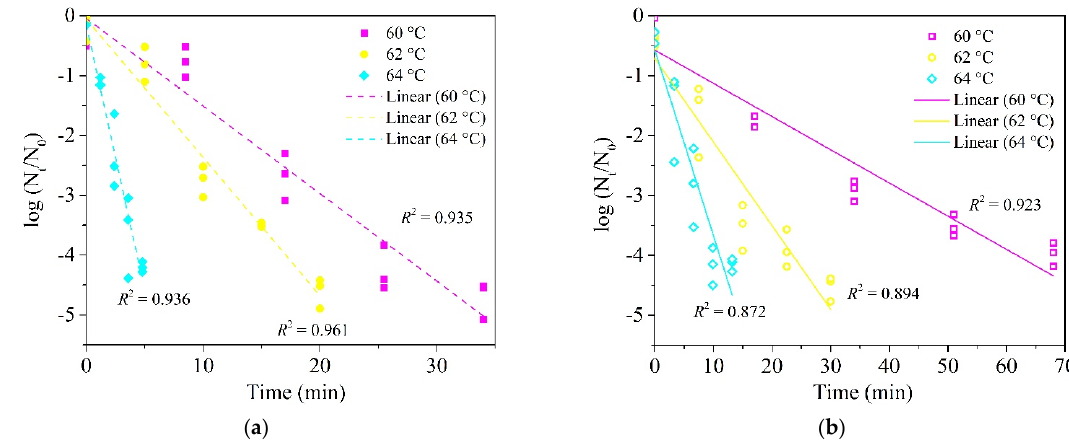
Figure 2. Inactivation kinetic curves of E. faecium in wheat granules (a w = 0.66) ( a ) and flour (a w = 0.65) ( b ) at 75, 80 and 85 °C under a fixed heating rate of 5 °C/min in the HBS.